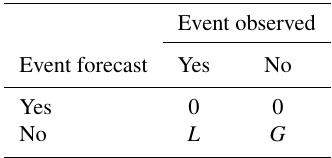
Table 3. Economical value assigned to the different outcomes of the contingency table ( L : loss; G :